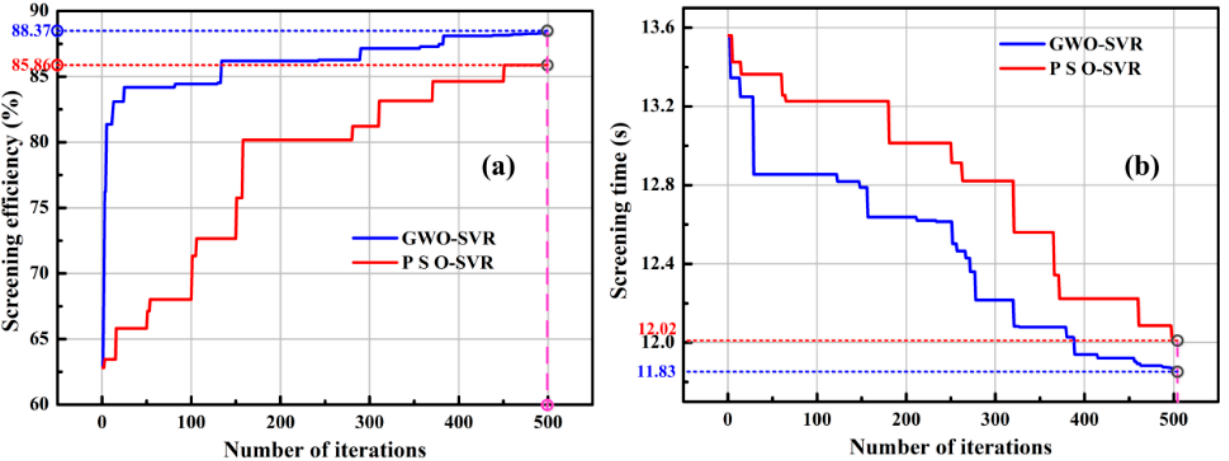
Figure 16. The optimization process for screening efficiency and time with GWO-SVR and PSO-SVR: ( a ) screening efficiency and ( b ) screening time.